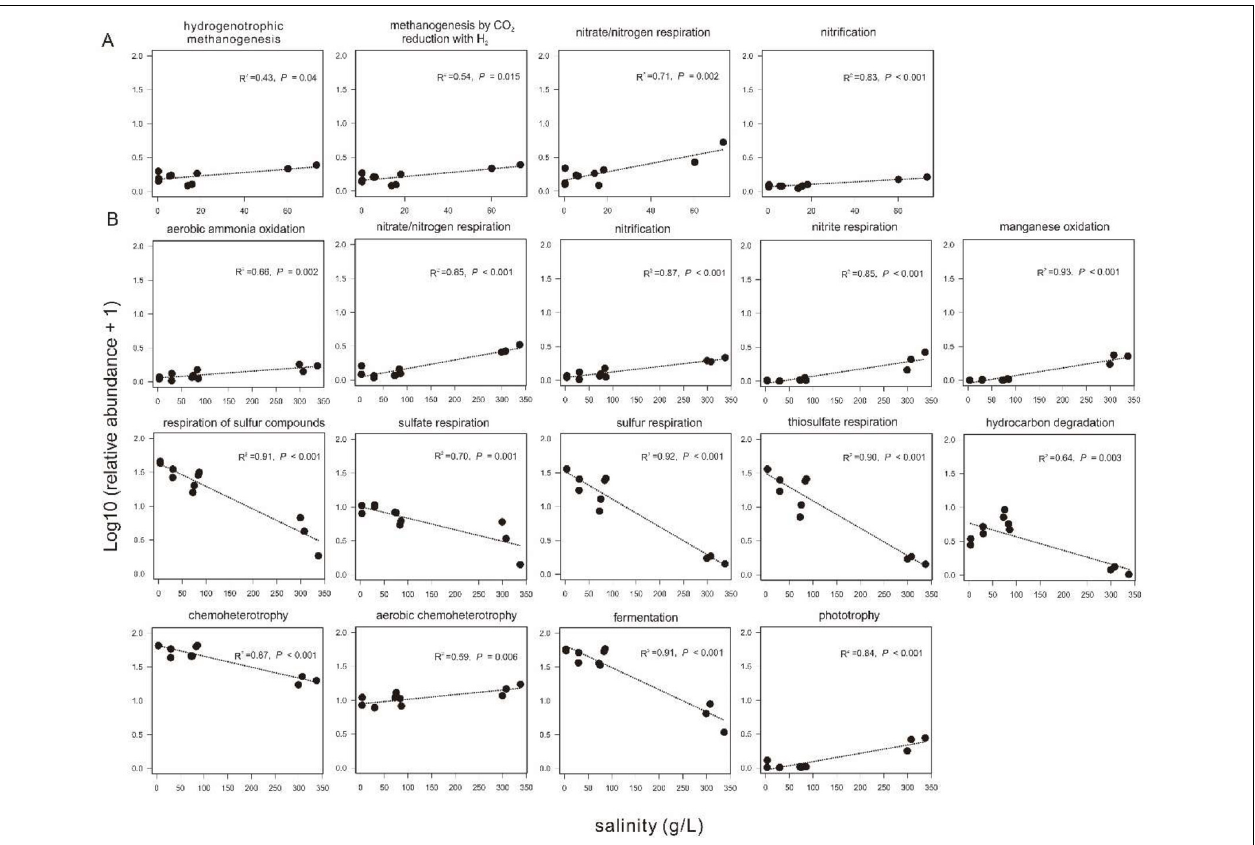
FIGURE 8 | Relationship between sediment salinity and relative abundances of potential microbial functions predicted by FARPROTAX. (A,B) are for experiment 1 (simulating salinization) and experiment 2 (simulating desalinization),